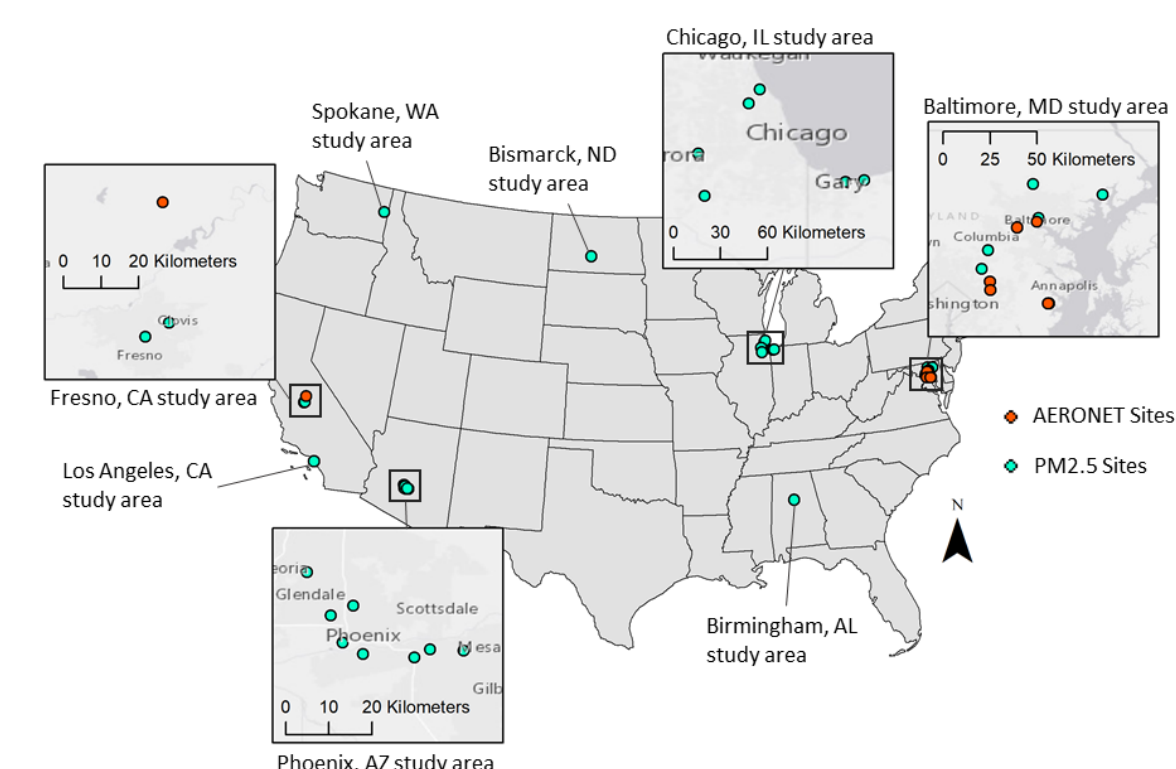
Figure 1. Point locations of the EPA AQS PM 2.5 and AERONET monitors utilized for this study. Insets zoom into study areas with multiple monitors. All eight U.S. cities considered regions of interest for this study are noted in the figure.